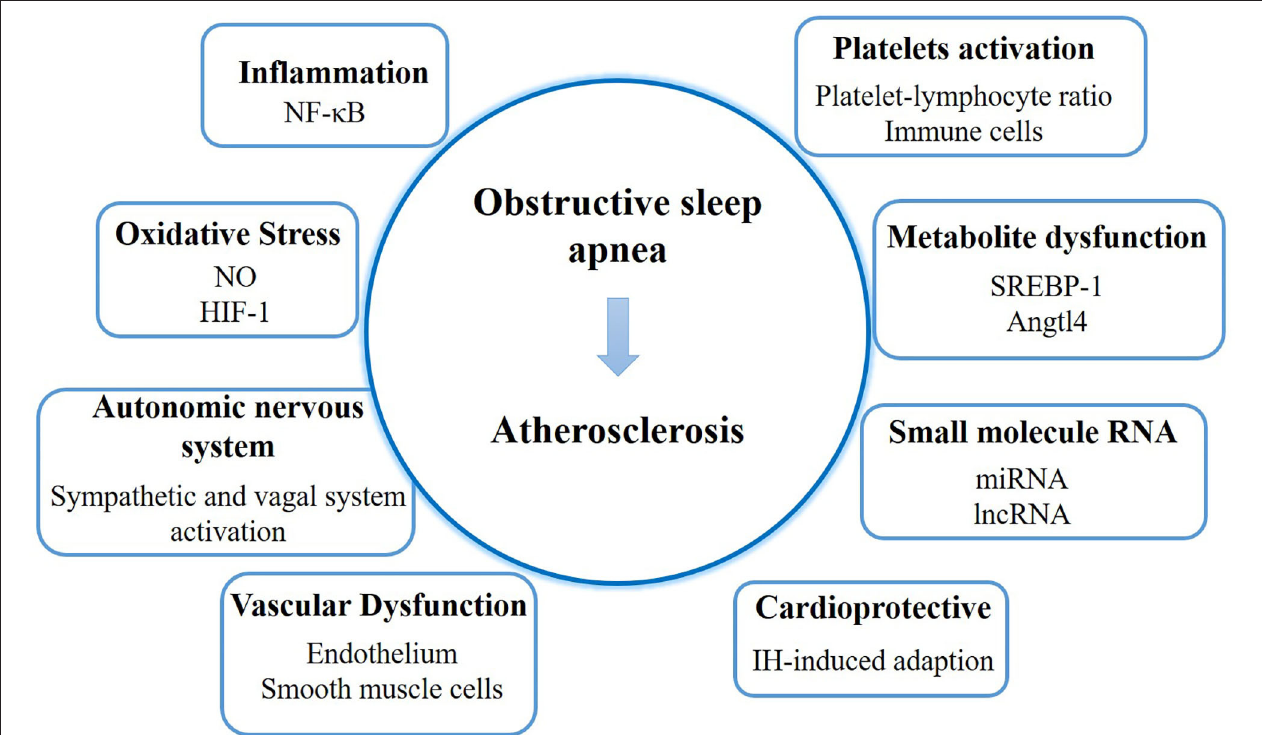
FIGURE 1 | The mechanism and latest discoveries of the link between obstructive sleep apnea and atherosclerosis. NO, nitric oxide; HIF-1, hypoxia inducible factor-1; IH, intermittent